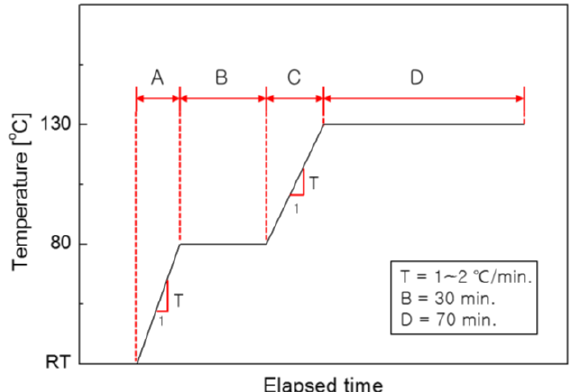
Figure 4. Typical curing cycle of the autoclave method.